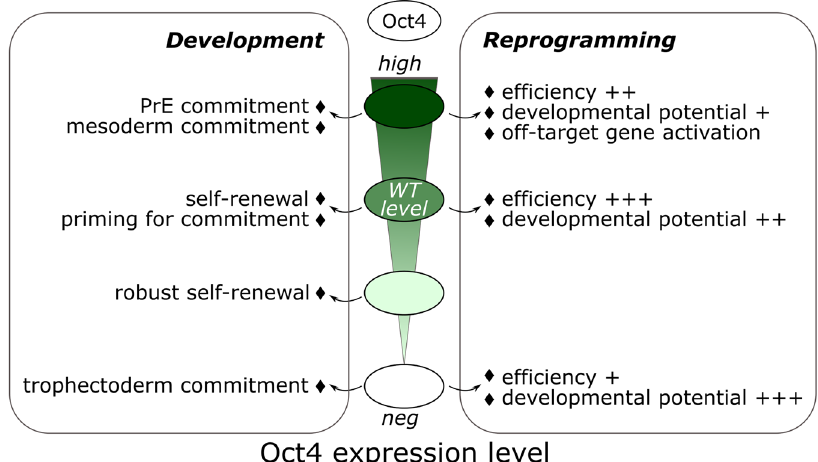
Fig.3|MolecularVersatilityofOct4duringdevelopmentandreprogramming. The schematic diagram depicts the different functions exerted by the TF Oct4 depending on its expression level. The expression of Oct4 is tightly regulated because gain and loss-of expression respectively triggering differentiation into primitive endoderm/mesoderm or trophectoderm derivatives in ESCs. Unexpect- edly, its endogenous level sustains self-renewal but also primes embryonic stem